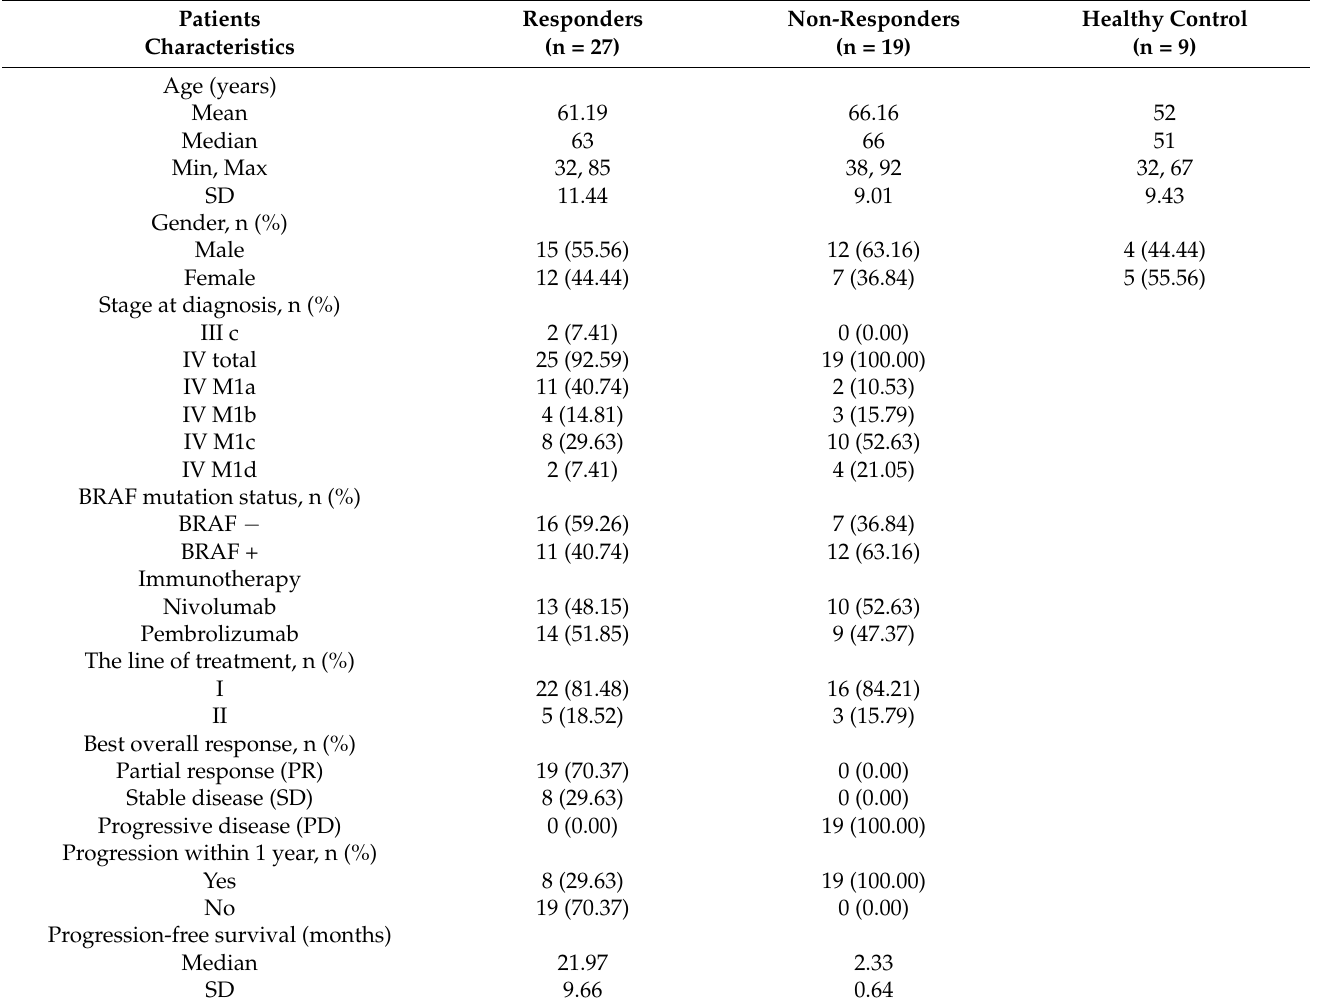
Table 1. Demographic and clinical data for advanced melanoma patients included in the study and healthy